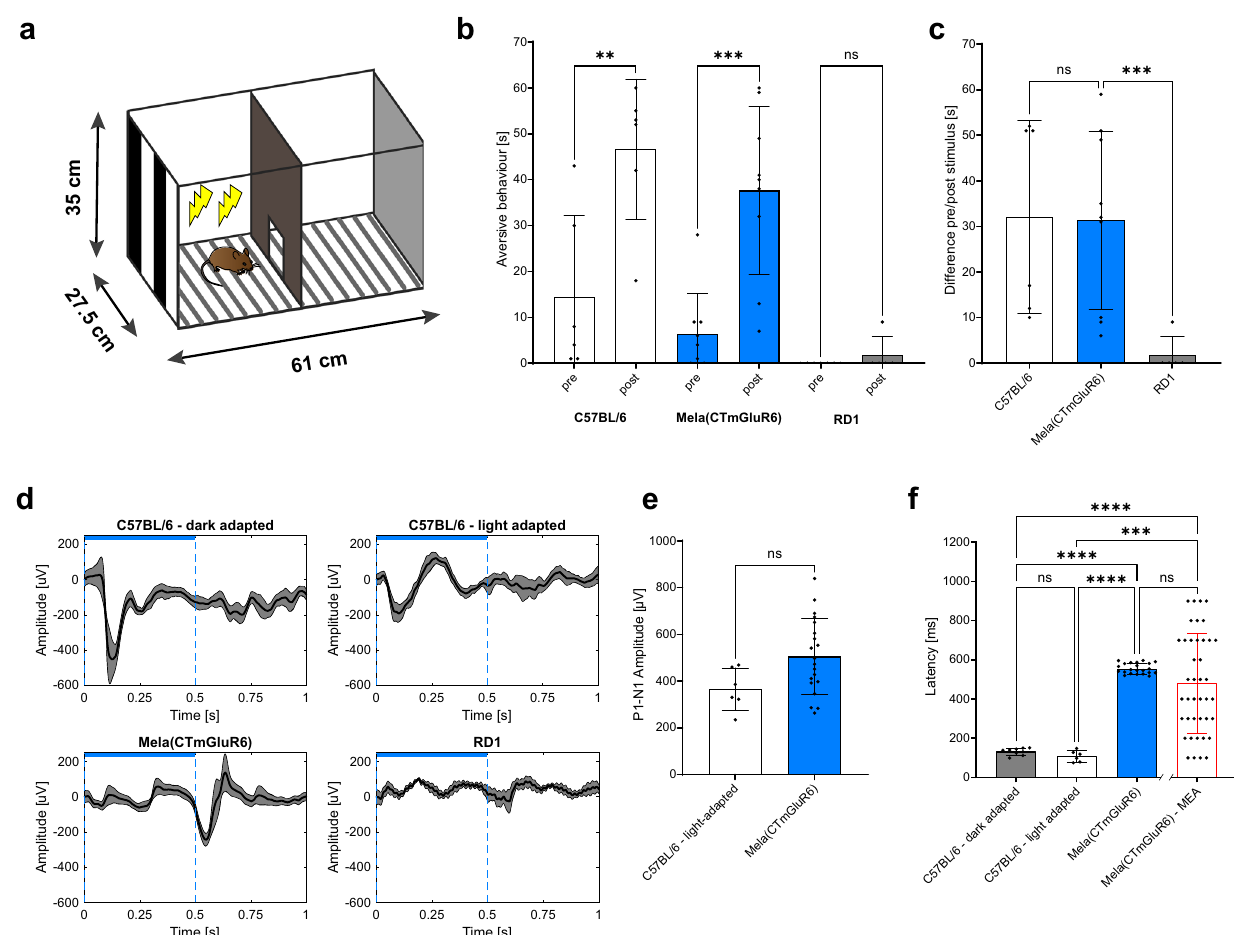
Fig. 7 Restoration of conditioned visually guided behavior. a Graphical depiction of the two-compartment visual conditioning paradigm to a moving grating (0.35 cyc/deg spatial frequency). b Comparison of aversive behaviors on day 4 before and during the pattern display increased signi fi cantly in C57BL/6 controls ( n = 6 animals; p = 0.00263) and Mela(CTmGluR6)-treated rd1 mice ( n = 9 animals; p = 0.00026), while non-treated rd1 mice did not show a behavioral response to the pattern stimulus ( n = 5 animals; p = 0.83). See Supplementary Movie M1 in the supplementary information for a typical behavior of a treated rd1 mouse in response to the drifting gratings. Comparison of 60 s pre-stimulus vs. 60 s during stimulus. c Stimulus-triggered aversive behavior was equally observed in Mela(CTmGluR6) injected rd1 mice ( n = 9) and healthy C57BL/6 mice (positive control, n = 6; p = 0.9935), but not in untreated rd1 littermates (negative control, n = 5; p = 0.00005). d Average VEP responses to a full- fi eld light stimulus (470 nm, 5 × 10 13 photons/cm 2 /s, 500 ms) in dark-adapted C57BL/6 animals ( n = 9 traces), light-adapted C57BL/6 animals ( n = 6 traces), Mela(CTmGluR6)-treated rd1 animals ( n =